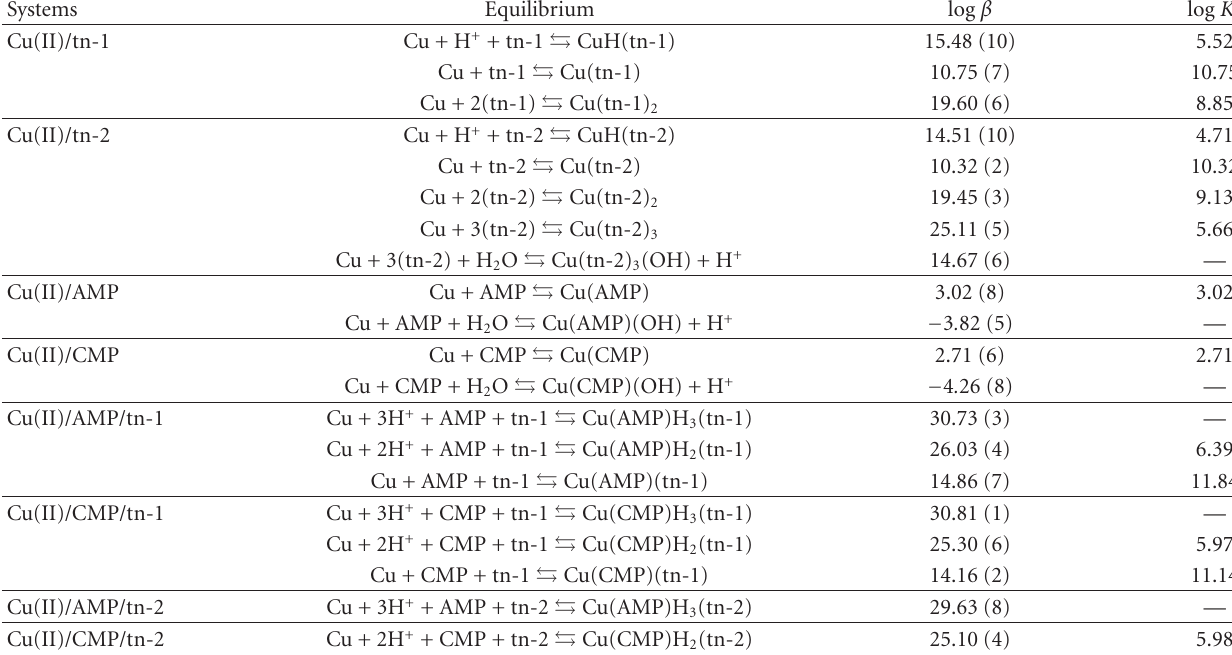
Table 3: Overall stability constants (log β ) and equilibrium constants (log K e ) of complexes formation in Cu(II)/tn-1 [49] , Cu(II)/tn-2 [49] , Cu(II)/AMP [15] , Cu(II)/CMP [15] , Cu(II)/AMP/tn-1, Cu(II)/AMP/tn-1, Cu(II)/CMP/tn-1, and Cu(II)/CMP/tn-2